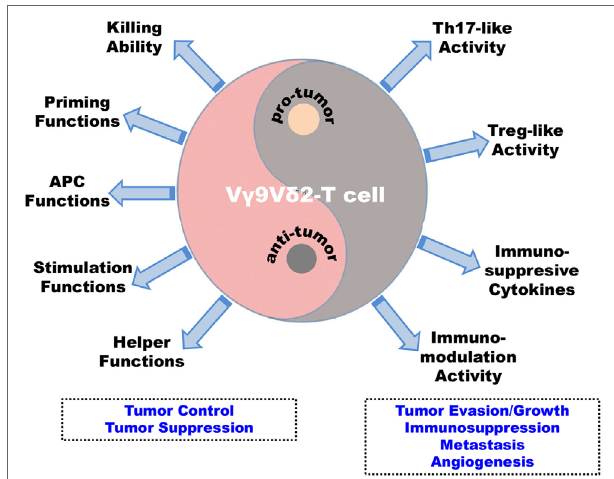
FigURe 3 | Antitumoral versus pro-tumoral activities of human V γ 9V δ 2-T cells. V γ 9V δ 2-T cells display dual effects in the immune surveillance against tumors, including antitumoral and pro-tumoral functions. on one hand, V γ 9V δ 2-T cells can control and suppress tumor development directly through potent cytotoxic capability and indirectly by regulating other innate and adaptive immune cells to establish antitumoral immune responses. First, V γ 9V δ 2-T cells can recognize and eliminate tumor cells with their potent killing ability. Second, they can promote dendritic cell maturation and macrophage activation. Third, V γ 9V δ 2-T cells can present antigens to αβ -T cells and iNKT cells. Fourth, they can stimulate and enhance NK cell antitumoral response. Finally, V γ 9V δ 2-T cells can help B cells produce antibodies. on the other hand, in the tumor microenvironment, the V γ 9V δ 2-T cells can be induced into Th-17-like cells and Treg-like cells by specific stimuli and they can secret immunosuppressive cytokines, such as IL-17, IL-10, and TGF- β , to suppress and modulate innate and adaptive antitumoral immunity. These strategies will be beneficial for tumor evasion/ growth, metastasis, and